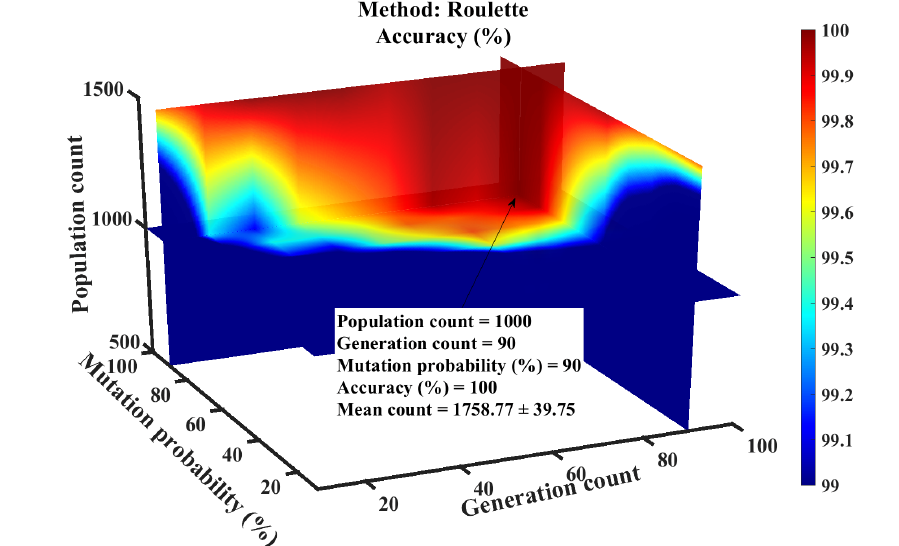
Figure 9. Multi-layer optimization using GA with roulette selection: accuracy (%) distribution data sliced at population size of 1000, generation count of 90, and mutation probability of